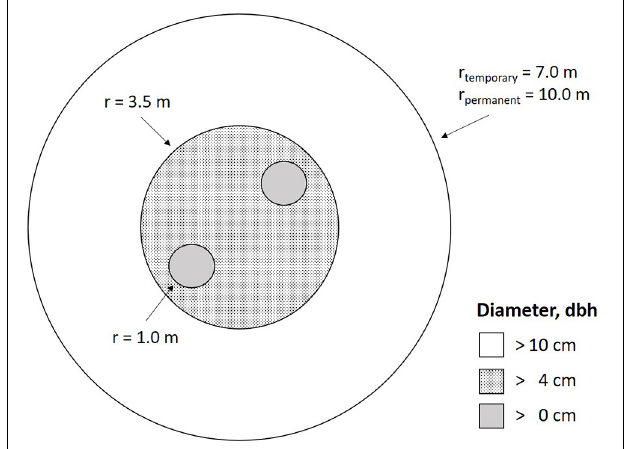
FIGURE 2 | Sample plot design used in the Swedish